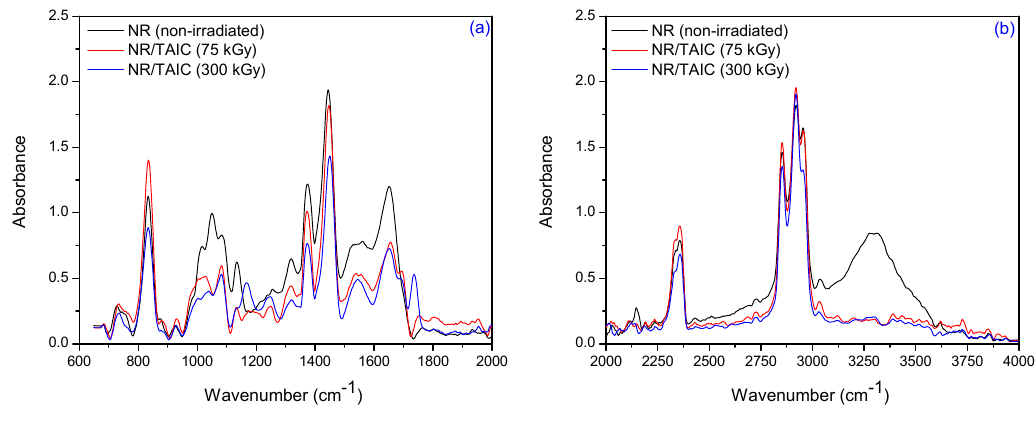
Figure 13. FTIR spectra in the range of ( a ) 2000 cm − 1 –600 cm − 1 and ( b ) 4000 cm − 1 –2000 cm − 1 for NR/TAIC samples, irradiated at 75 kGy and 300 kGy.